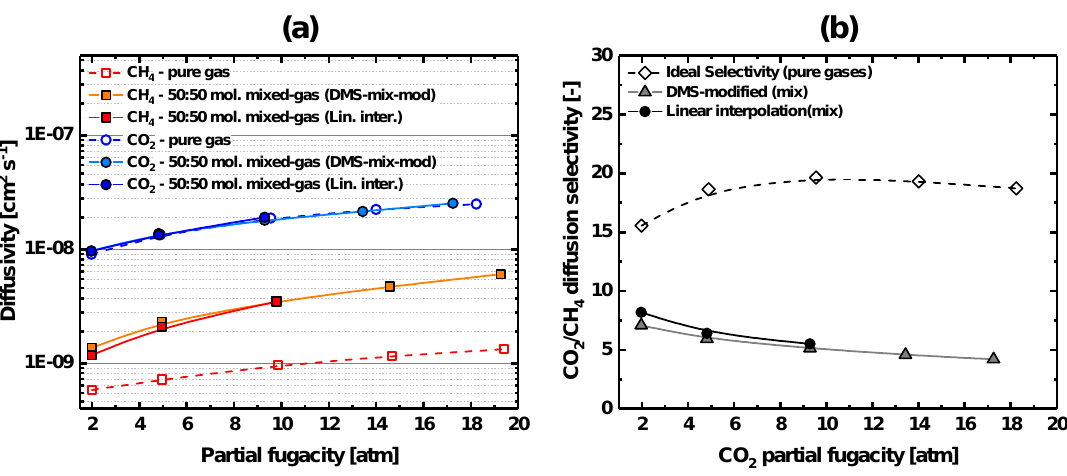
Figure 9. ( a ) CH 4 and CO 2 pure- and mixed-gas diffusion coefficients (6FDA-mPDA) vs. partial fugacity; ( b ) CO 2 /CH 4 pure- and mixed-gas diffusion selectivity vs. CO 2 partial fugacity. Lines are drawn to guide the